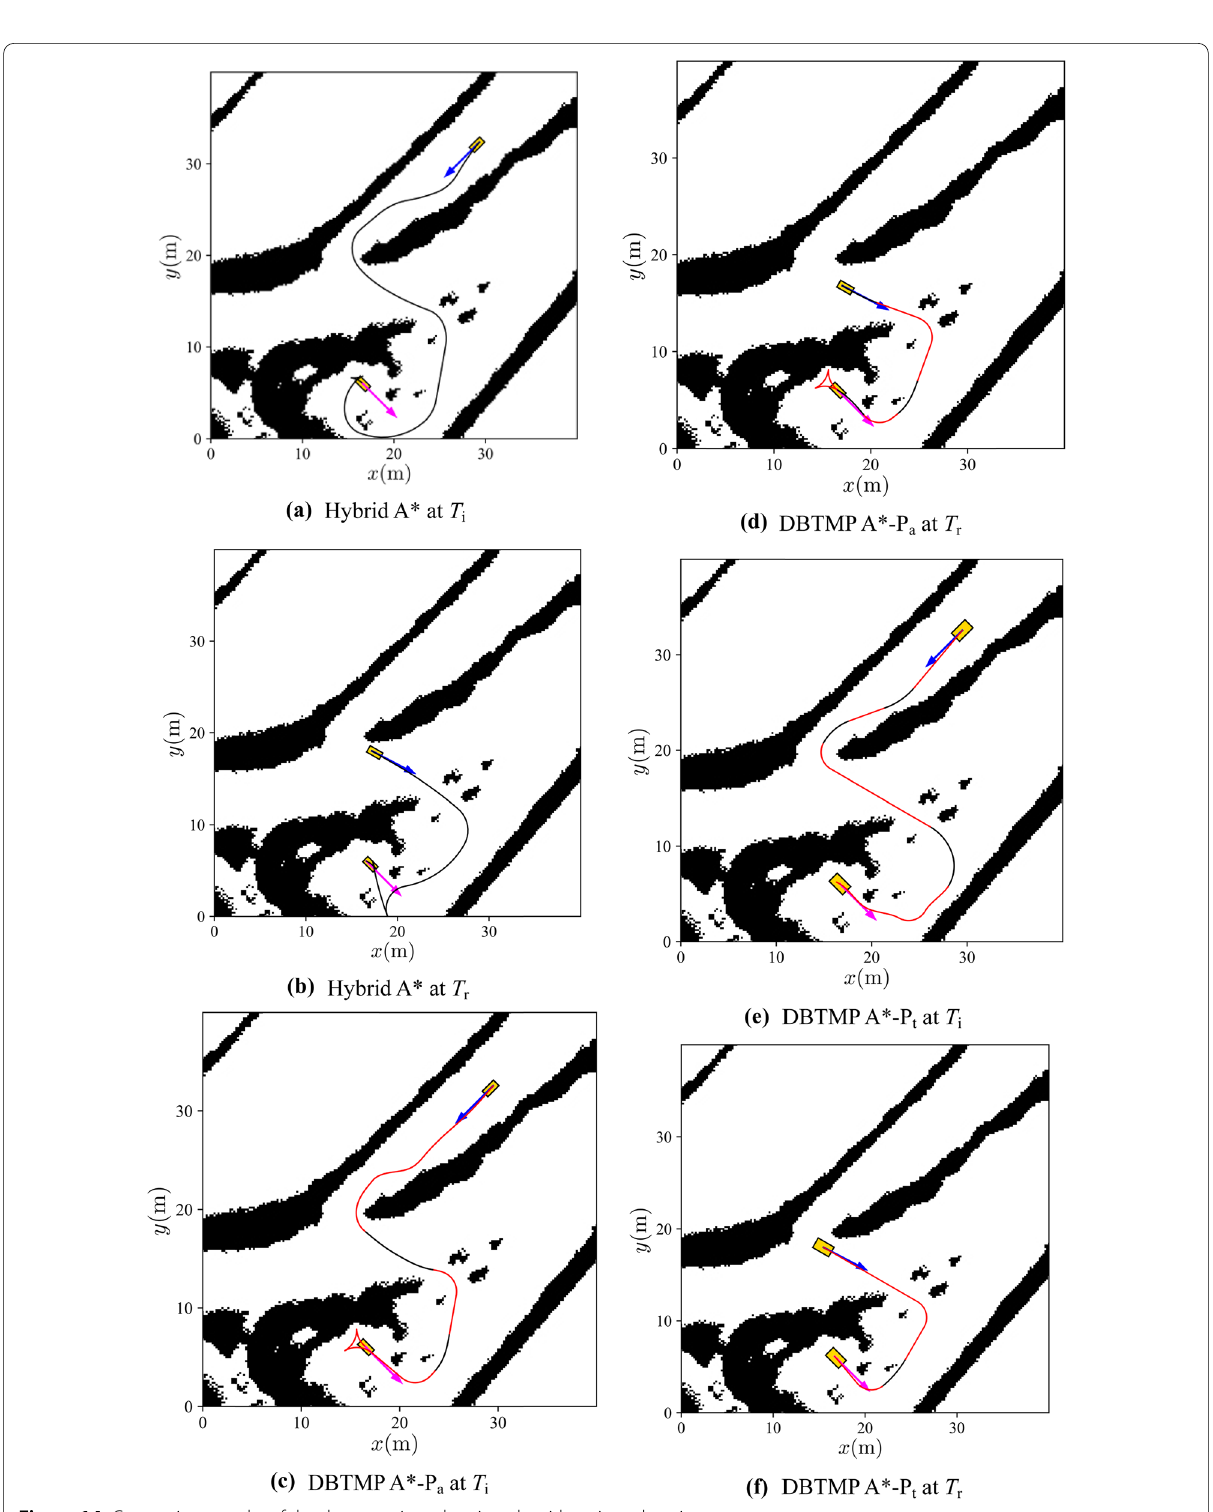
Figure 14 Comparison results of the three motion-planning algorithms in real